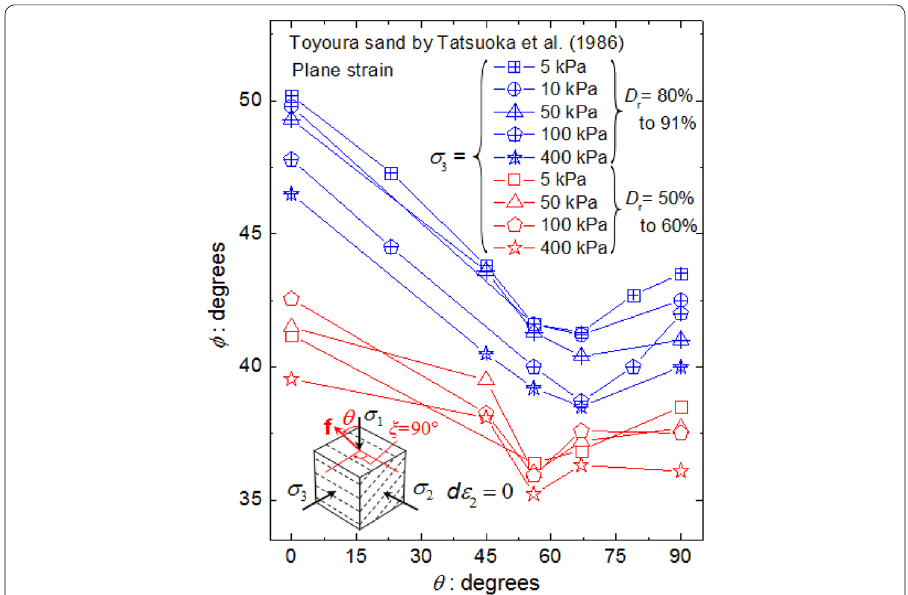
Fig. 4 Anisotropic strength of Toyoura sand in plane strain compression